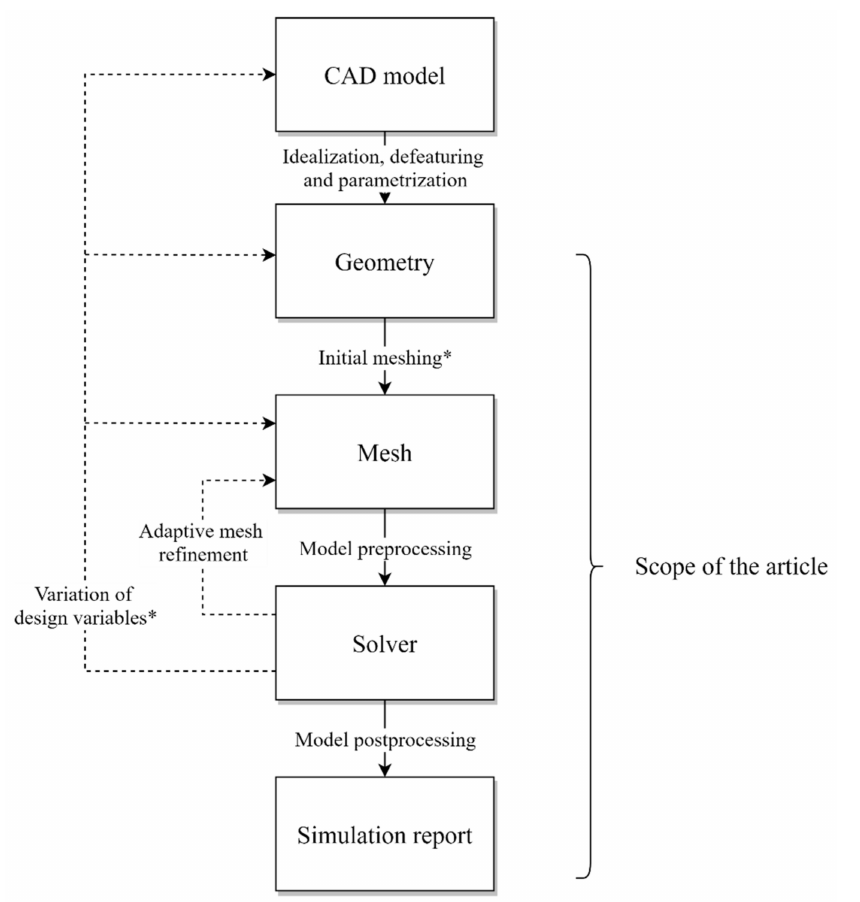
Figure 2. Overview of an engineering simulation process and the scope of our article. Process steps marked with an asterisk (*) can require (partial) user